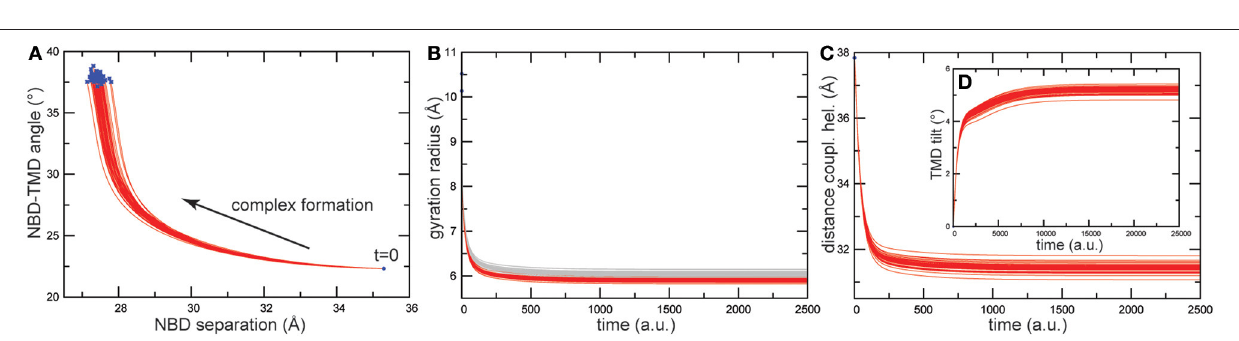
FIGURE 7 | Trajectories of conformational changes in HmuUV. Trajectories characterizing conformational motions along the formation of ligand-complexed structures are shown for 50 different ligand-binding realizations. (A) Trajectories showing changes in the distance between the NBDs and in the orientation of the TMDs relative to the NBDs, subsequent to binding of the two ligand beads. They evidence the coupling between closing motions of the NBDs and relative global rotation of the TMDs. (B) Changes in the gyration radius of each nucleotide-binding pocket are shown as red and gray curves. Changes in the distance between the coupling helices (C) , and in the tilt of one TMD (D) are displayed (see Materials and